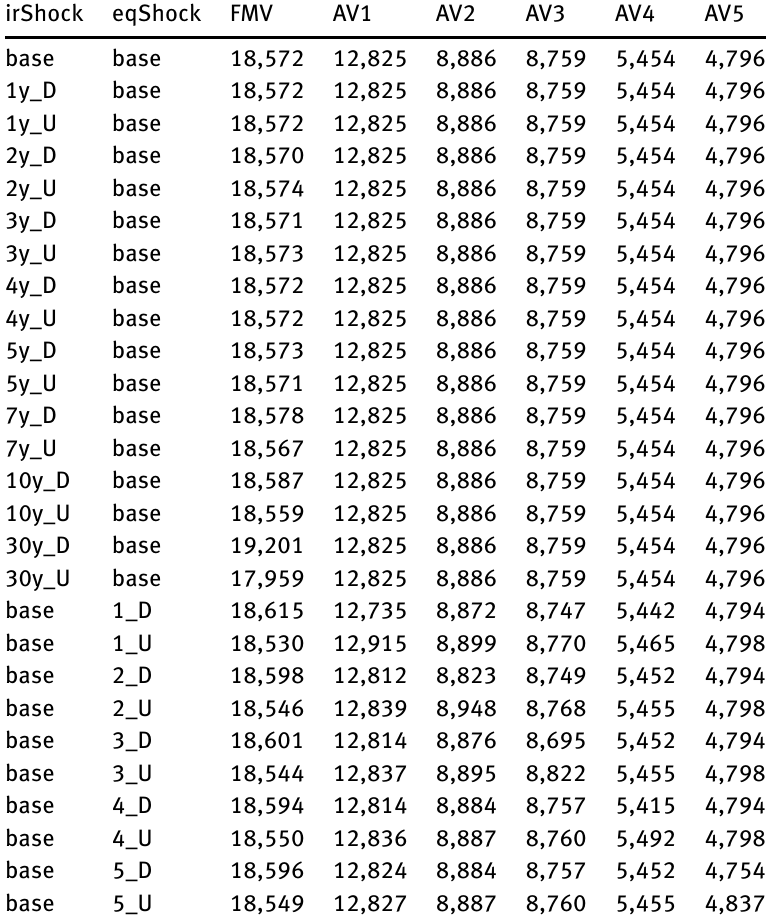
Table 9: Fair market values and partial account values for different combinations of interest rate shocks and equity shocks. The numbers are in millions and “base” means no shocks are applied. Note that 1y_D and 1y_U mean shocking the 1 year rate down and up 10 bps, respectively. 1_D and 1_U mean shocking the the first index down and up 1%,